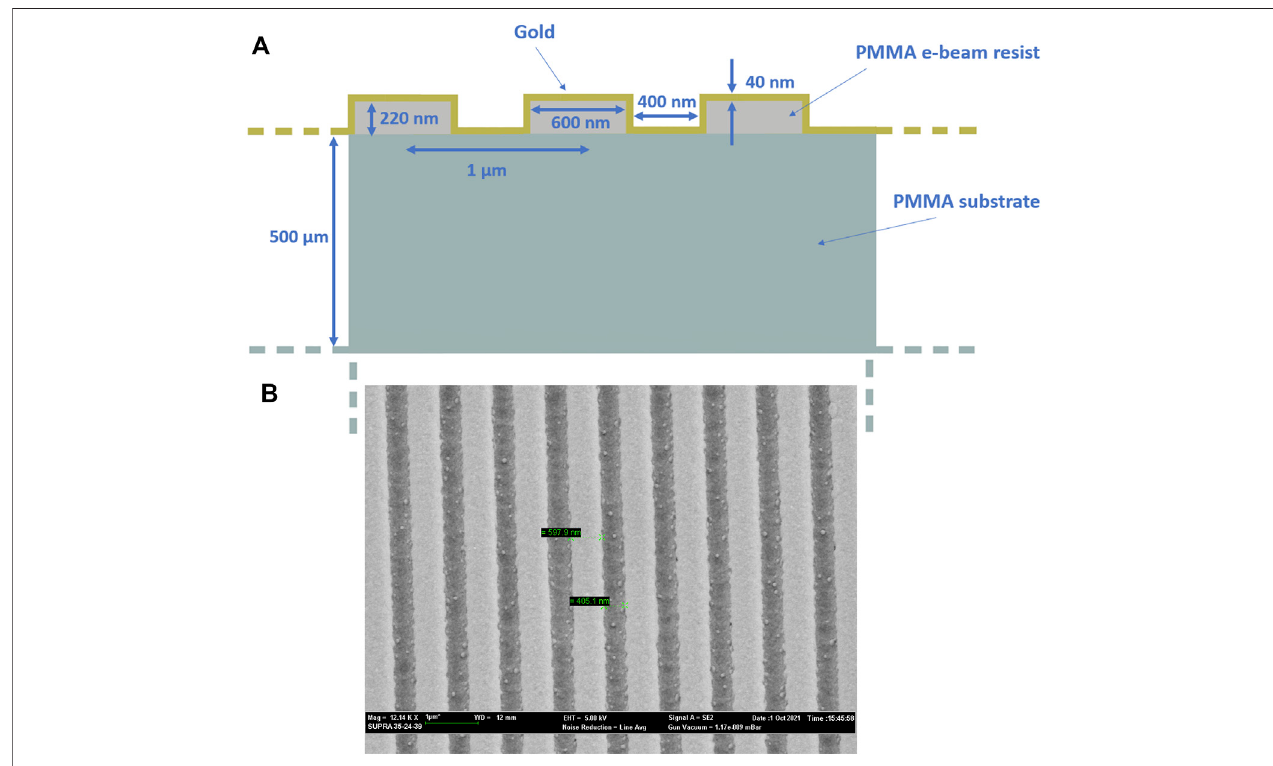
FIGURE 2 | (A) Cross-section of the GNG. (B) SEM image of the GNG.